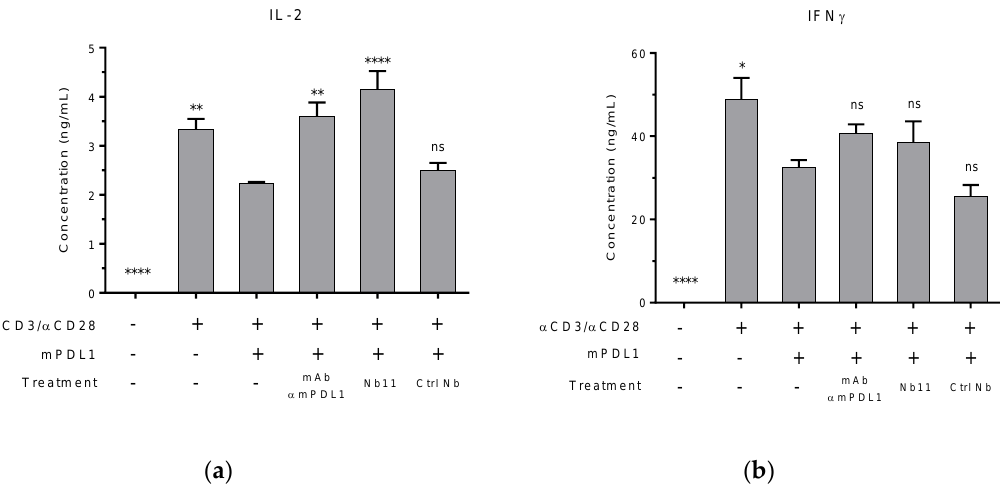
Figure 3. Nb11-mediated restoration of activity markers in mouse primary T cells. T cells were activated with antibodies against CD3 and CD28, in the presence or absence of mPD-L1. Cells were incubated with Nb11, an anti-mPD-L1 control mAb, a control Nb (Ctrl Nb) or without antibodies. After 72 h of incubation, supernatants were collected and levels of ( a ) IL-2 (interleukin 2) and ( b ) IFN ɣ (interferon gamma) were measured by ELISA. Data represent the mean + SEM. Statistical analysis was performed using one-way ANOVA test with Dunnett’s multiple comparison test, using as reference group the third column (activation with antibodies and mPD-L1, without treatment). One representative experiment out of two performed is shown. * p < 0.05; ** p < 0.01; **** p < 0.0001, ns: not significant.